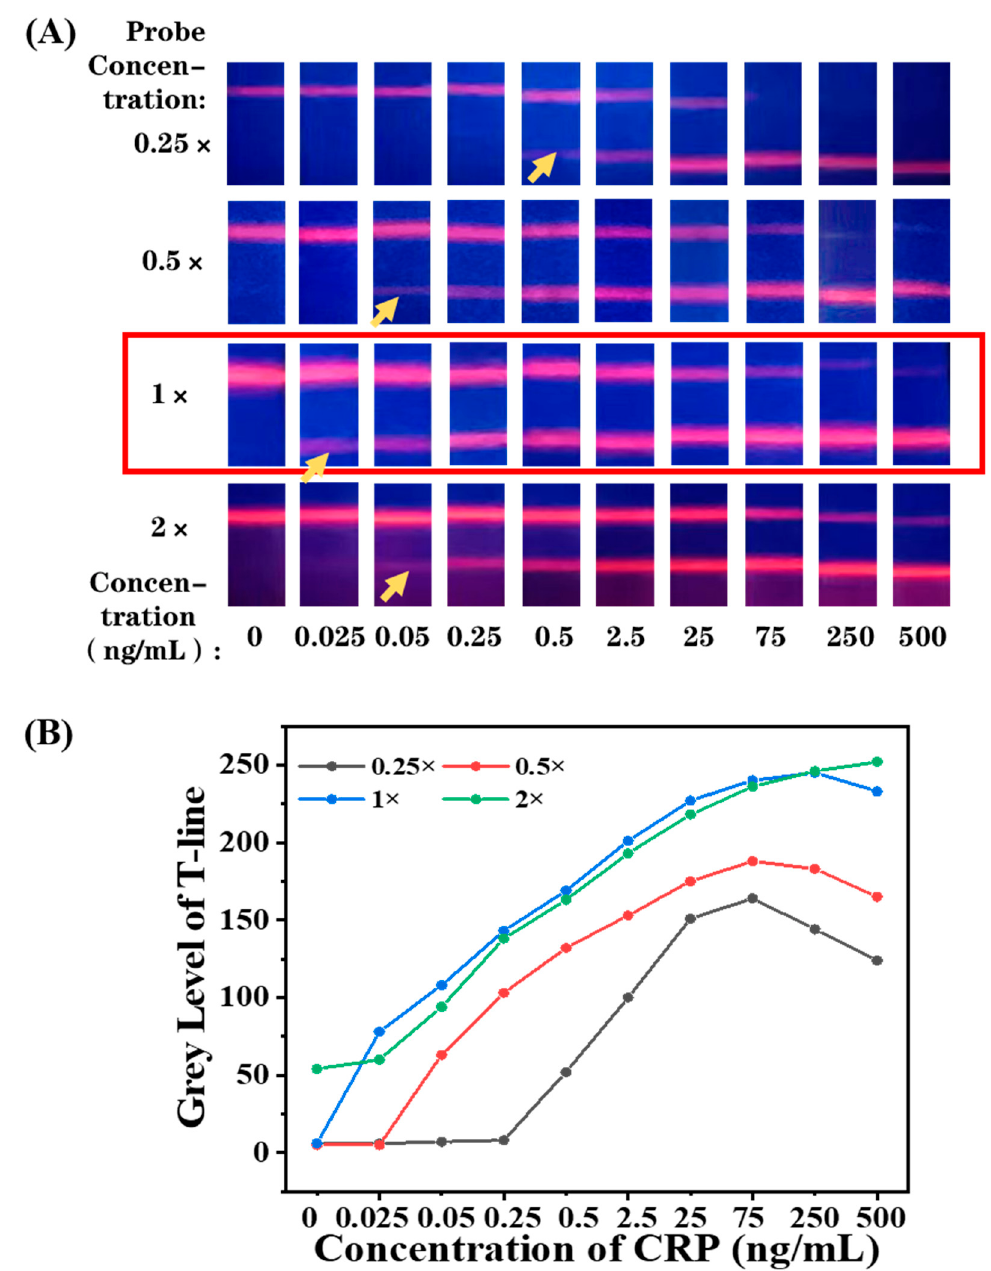
Figure 5. ( A ) The fluorescence photos of LFIA with different EuPSM-antibody concentration. ( B ) The relationship curve of fluorescence band intensity and CRP concentration with different EuPSM- antibody concentrations.